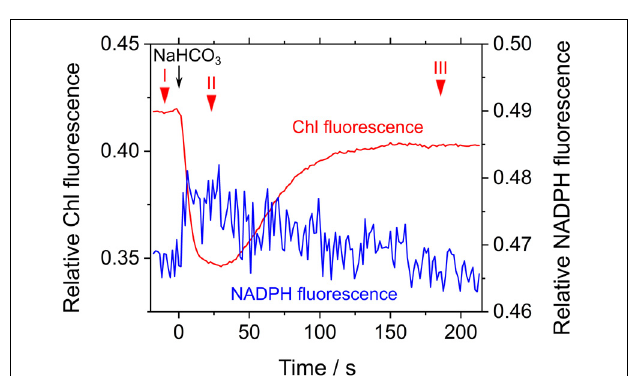
FIGURE 4 | Effects of exogenous NaHCO 3 on relative chlorophyll (Chl, red line) and NADPH (blue line) fluorescence in phase β in Synechococcus elongatus PCC 7942. Black arrow shows the point in time at which NaHCO 3 (50 µ M) was added. The incident quantum yield of PSII, Y(II), was measured at the points in time indicated by red inverted triangles: I, 0.028 ± 0.006; II, 0.12 ± 0.02; and III, 0.029 ± 0.007 (mean ± standard deviation, n = 3). The line graphs show the representative results of three experiments (technical replicates).